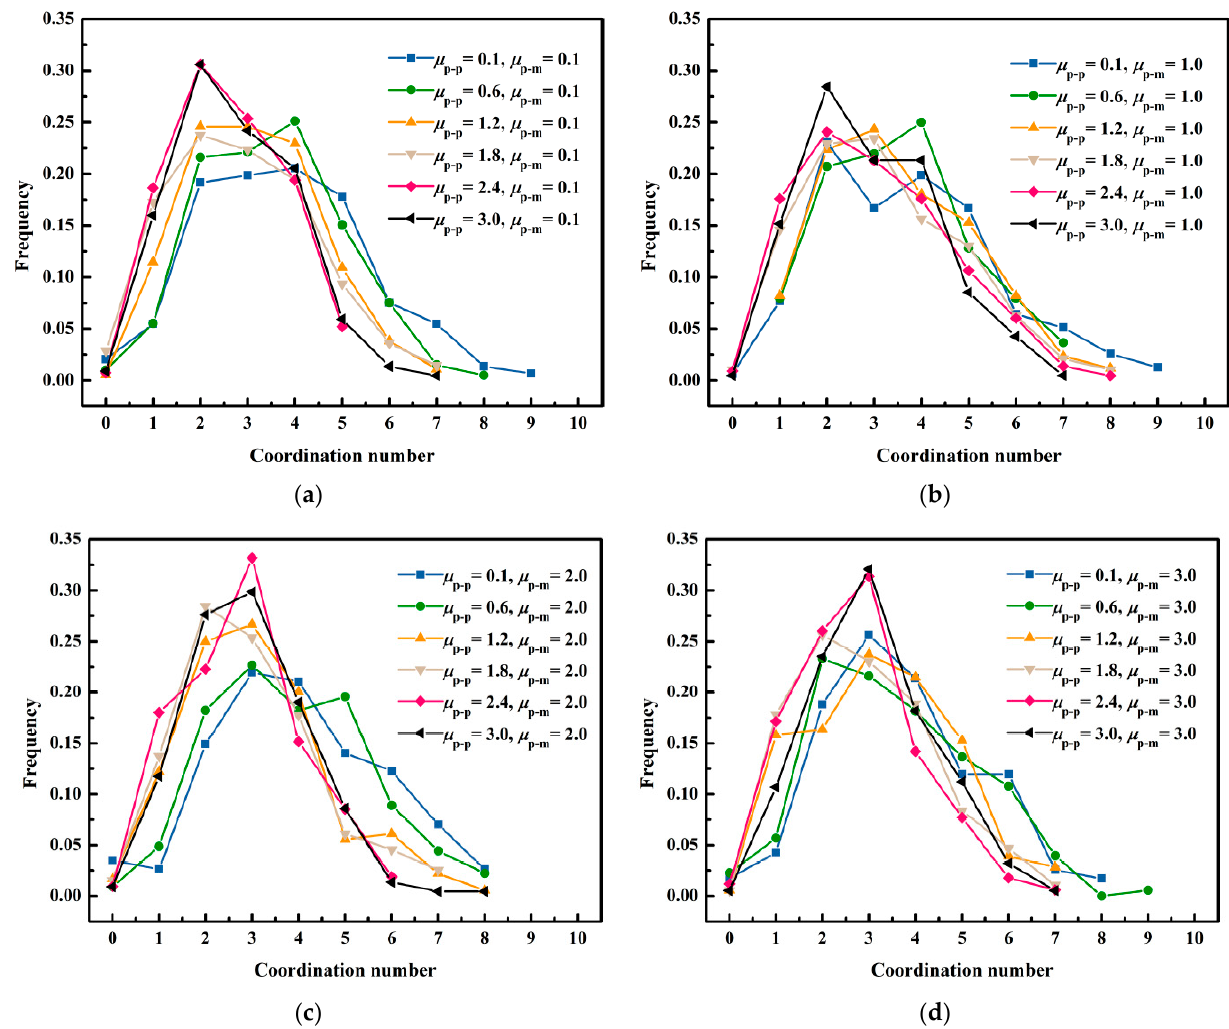
Figure 9. Impacts of the rolling friction coefficient among the lignin particles on coordination number distribution. ( a ) µ p − m = 0.1; ( b ) µ p − m = 1.0; ( c ) µ p − m = 2.0; ( d ) µ p − m = 3.0.